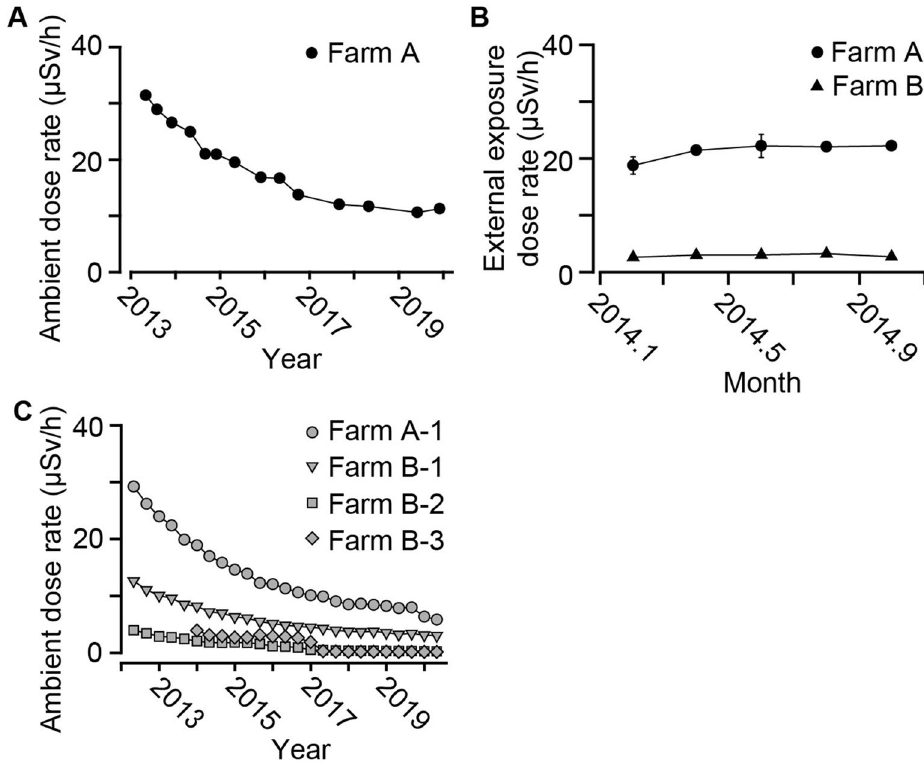
Figure 1. The ambient dose rate in farms and external dose of exposed cattle. The ambient dose rate and external dose of exposed cattle were measured. ( A ) The summary of ambient dose rate at Farm A (black circle, n = 10–73). ( B ) The summary of external dose rate of exposed cattle (Farm A, black circle, n = 17–20, respectively; Farm B, black triangle, n = 11). ( C ) The summary of ambient dose rates around Farm A and B; Farm A-1 (gray circle), B-farm-1 (gray triangle), 2 (gray square), and 3 (gray rhombus). The places of them were shown in Fig. S1B. Data are presented as mean ±